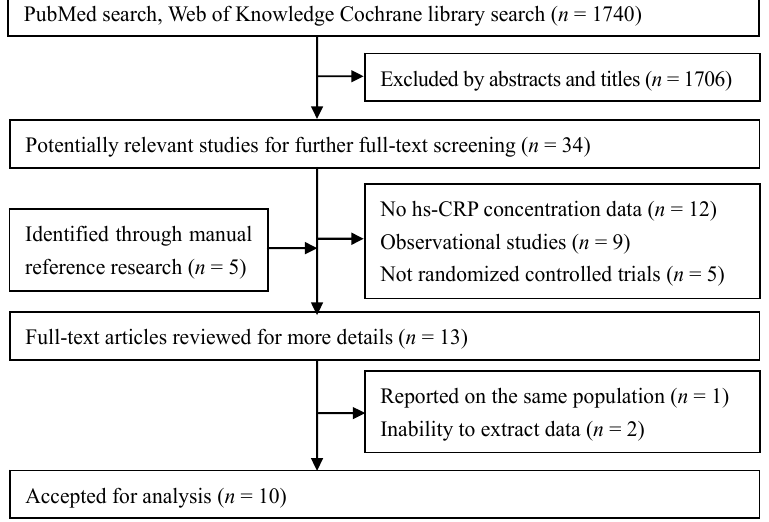
Figure 1. Flow chart of literature search and study